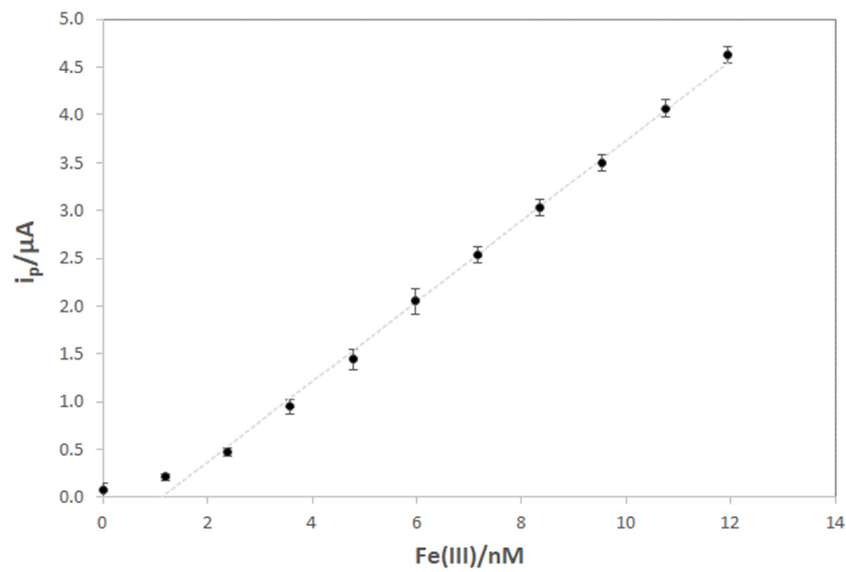
Figure 5. Calibration curve for Fe(III) determination by DPV. The procedure and conditions are described in the text and caption of Figure 4. Each point is the average value of measurements obtained with five different screen-printed cells. Error bars correspond to the standard deviation of the measurements performed with five electrodes.